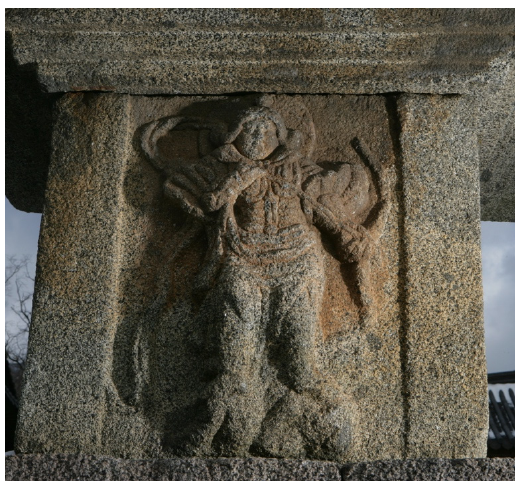
Figure 6. Four heavenly kings, Unified Silla, ninth century, first body of western stone pagoda,